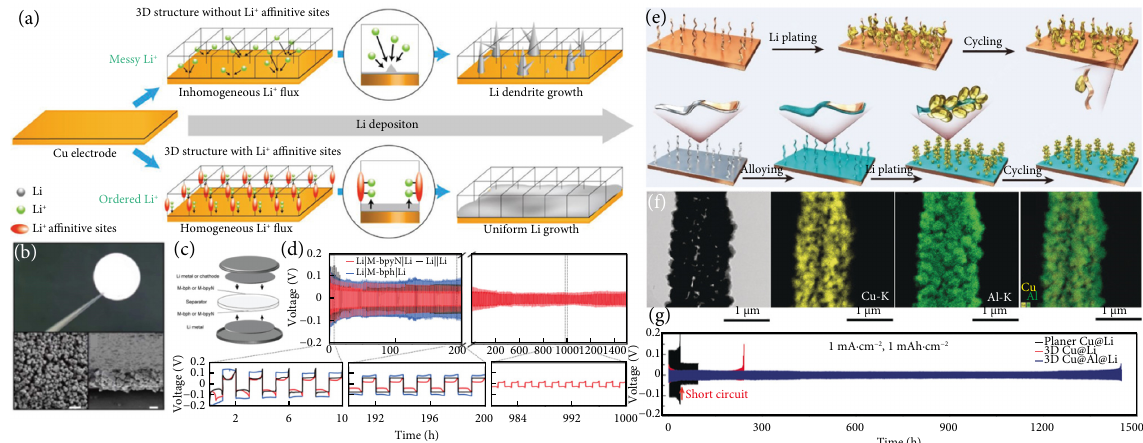
Fig. 4 (a) Diagram of inhomogeneous and homogenous Li flux on Cu current collectors. (b) SEM image of M-bpyN@Cu. (c) Schematic of cell assembling using M- bpyN layers. (d) Charge-discharge profile of Li||Li, Li|M-bph|Li, and Li|M-bpyN|Li for long-term cycling at a current density of 1.0 mA·cm −2 . (a–d) Reprinted with permission from ref. [27], © 2020 The Authors. (e) Schematic of the Li plating process on the 3D Cu foil and 3D Cu@Al foil. (f) Bright-field TEM (STEM) image and the corresponding Cu, Al, and overlapped element mapping images of the 3D Cu@Al foil. (g) Voltage profiles of metallic Li plating/stripping in three styles of symmetric cells (planar Cu@Li, 3D Cu@Li, and 3D Cu@Al@Li) at 1 mA·cm −2 for 1 mAh·cm −2 . (e–g) Reprinted with permission from ref. [52], © 2019 Wiley-VCH Verlag GmbH&Co.